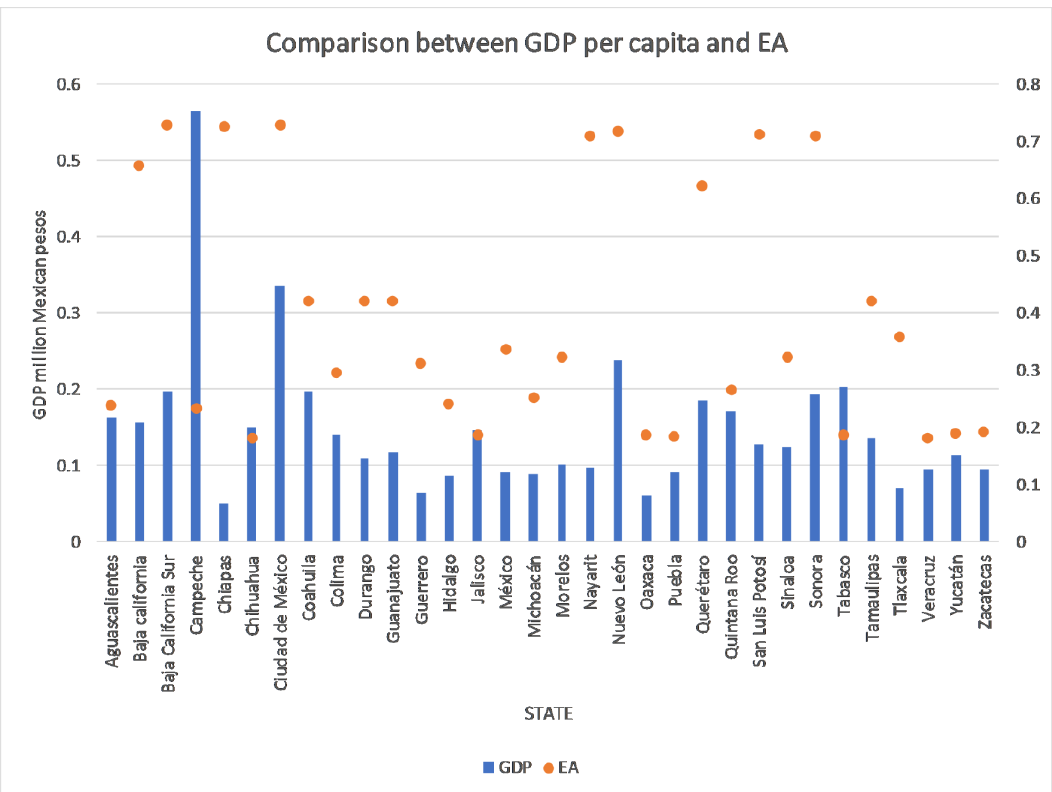
Figure 10. Comparison between GDP per capita and EA by state.